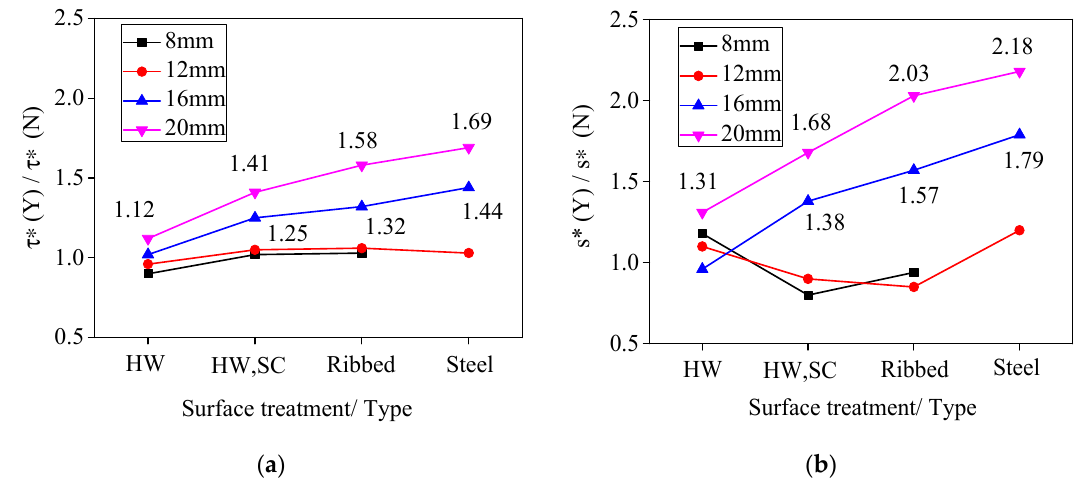
( c ) Figure 12. Typical cracking behavior of specimens ( a ) R4-C1-20-N-1, ( b ) R3-C1-20-Y-2, and ( c ) R4-C1- 20-Y-2. Figure 13 shows the ratio of the average bond strength ( τ * (Y) / τ * (N)) and the corresponding average slip ( s* (Y) / s* (N)) of the specimens with and without stirrups. It is evident that the τ * and s * of specimens that contain stirrups will be increased if their stirrup-lacking counterparts undergo concrete splitting failure. The larger the diameter of the similar bars, the more evident was the improvement in its performance. Different types of bars ranged in the amount of ostensible improvement, from R1, R2, R3, and R4 bars with same diameter. The τ * (Y) / τ *(N) and s * (Y) / s* (N) values of R2, R3, and R4 bar of the 16mm diameter were 1.25, 1.32, 1.44 and 1.38, 1.57, 1.79, respectively; while the values of R1, R2, R3, and R4 bar of 20mm diameter were 1.12, 1.41, 1.58, 1.69 and 1.31, 1.68, 2.03, 2.18, respectively. This may be because the larger the diameter and bond stress between the bar and concrete, the higher the likelihood of the occurrence of concrete splitting failure, which in turn renders an increase in the confinement of stirrups on concrete. In addition, no splitting cracks were apparent in specimens that underwent pullout failure. The τ - s curves of specimens with and without stirrups were basically identical (Figures 5–8), and the values of τ * (Y) / τ *(N) and s * (Y) / s * (N) are close to 1 (Figure 13). This observation can be reckoned to the work by Malvar [18], who imposed different circumferential constraining forces onto the